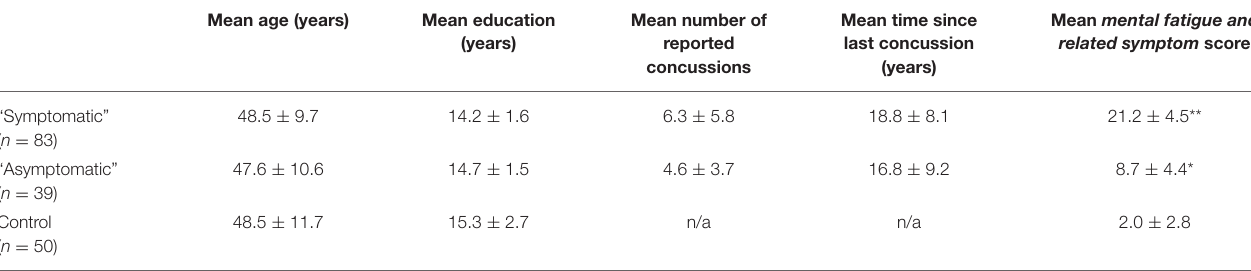
TABLE 1 | Participant demographics and related symptom survey score.